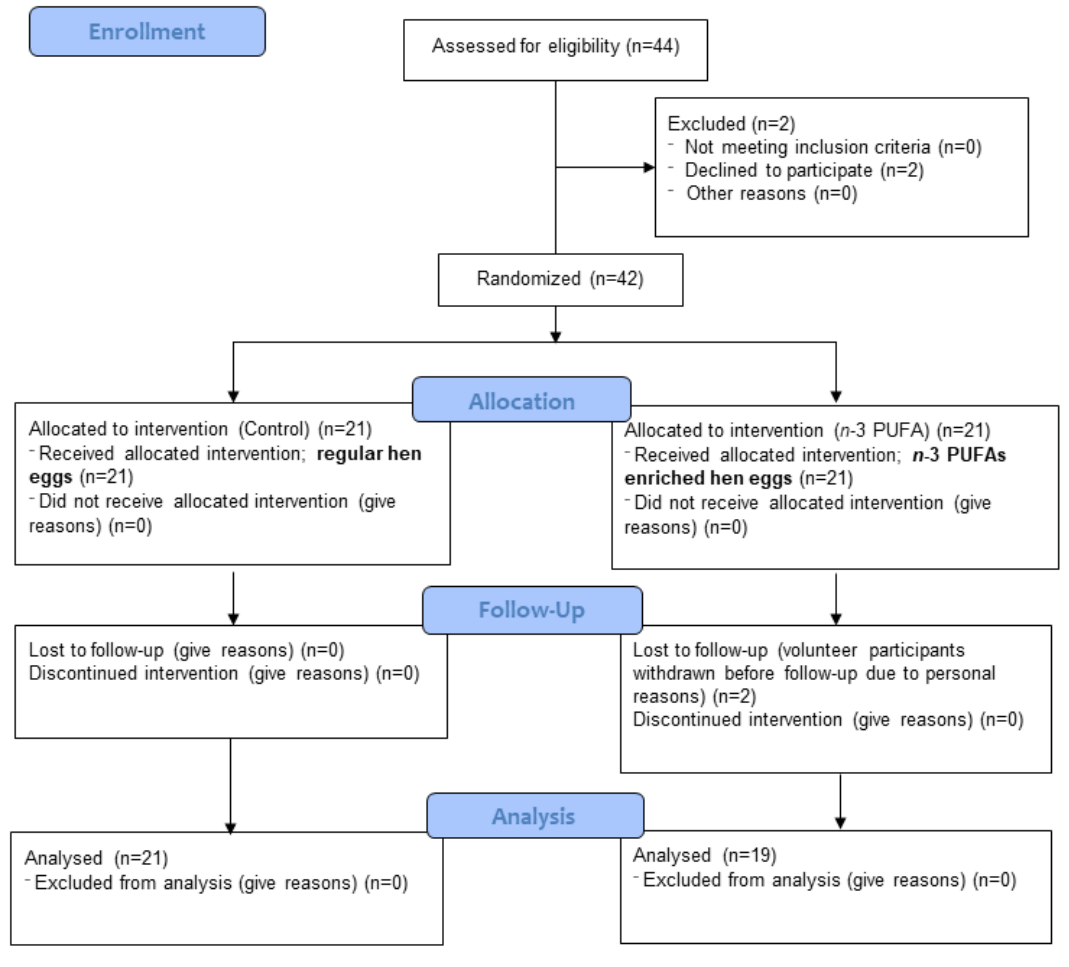
Figure 1. CONSORT 2010 flow diagram.